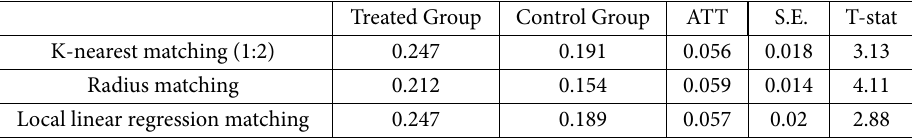
Table A2. Average treatment effect of government subsidies on economic performance Treated Group